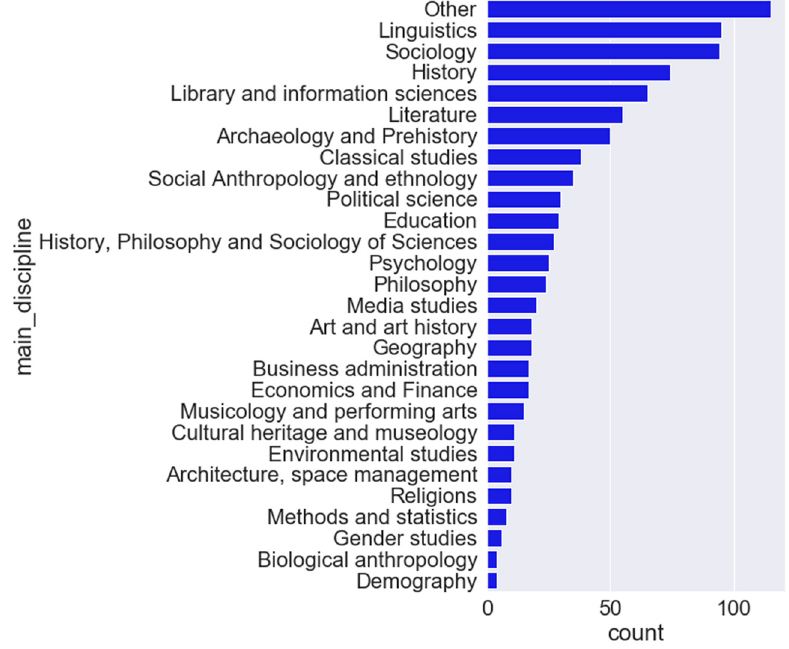
Figure 10. Main Figure 10. Main discipline. Figure 10. Main discipline.